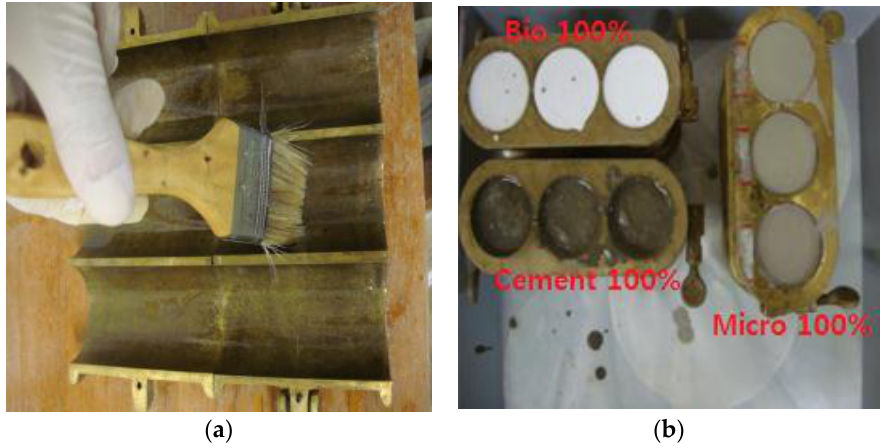
Figure 2. Making of homogenous gel specimens for the grouting material: ( a ) application of lubricant to specimen molds; and ( b ) curing.